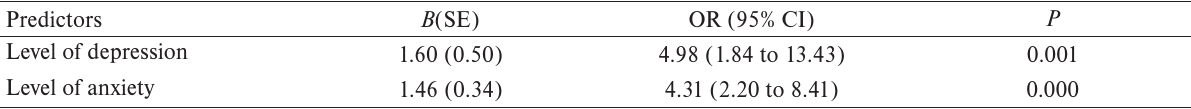
Table 3. Predictors of insomnia, results of logistic regression